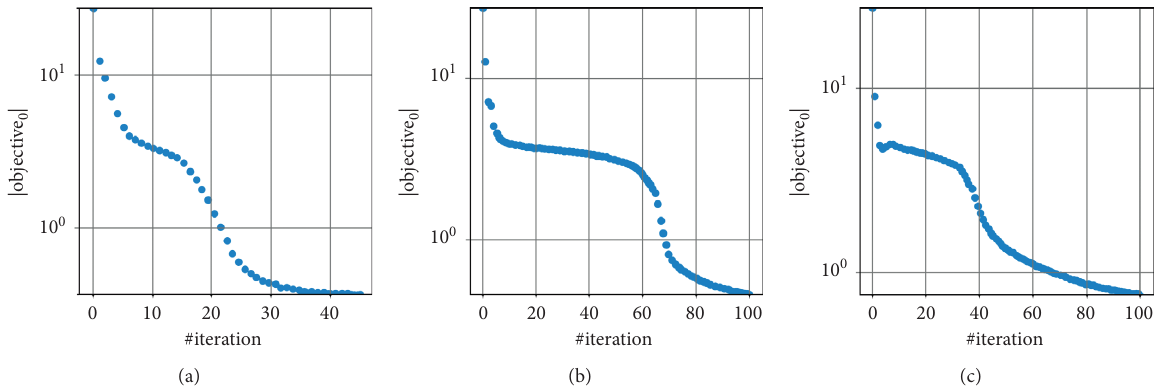
Figure 4: Comparison of networks’ convergence toward the exact solution of Example 1 using (a) Adam optimizer, (b) SGD optimizer, and (c) RMSprop ( η � 0 . 01 )